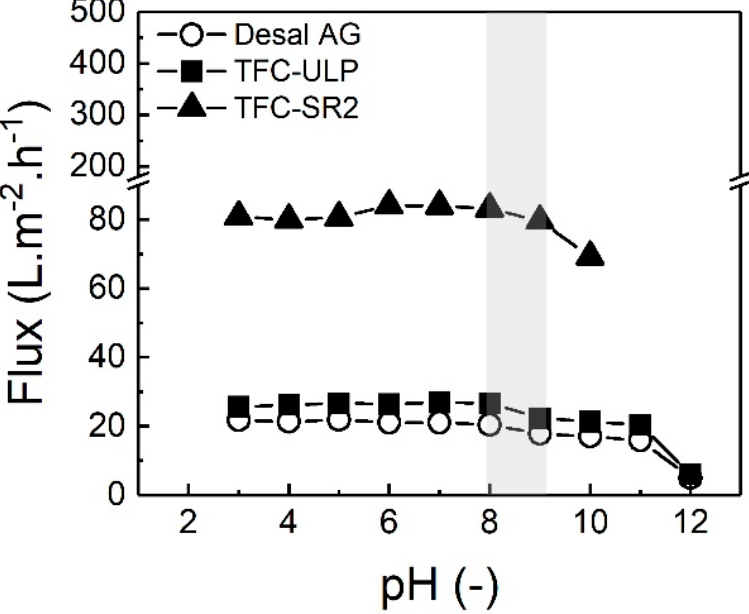
Figure 9. Permeate flux of three membranes as a function of pH (3–12) with groundwater sample 5. The grey area represents the pH range of groundwater 1–5. The applied pressure was 10 bar, data adapted from [69].